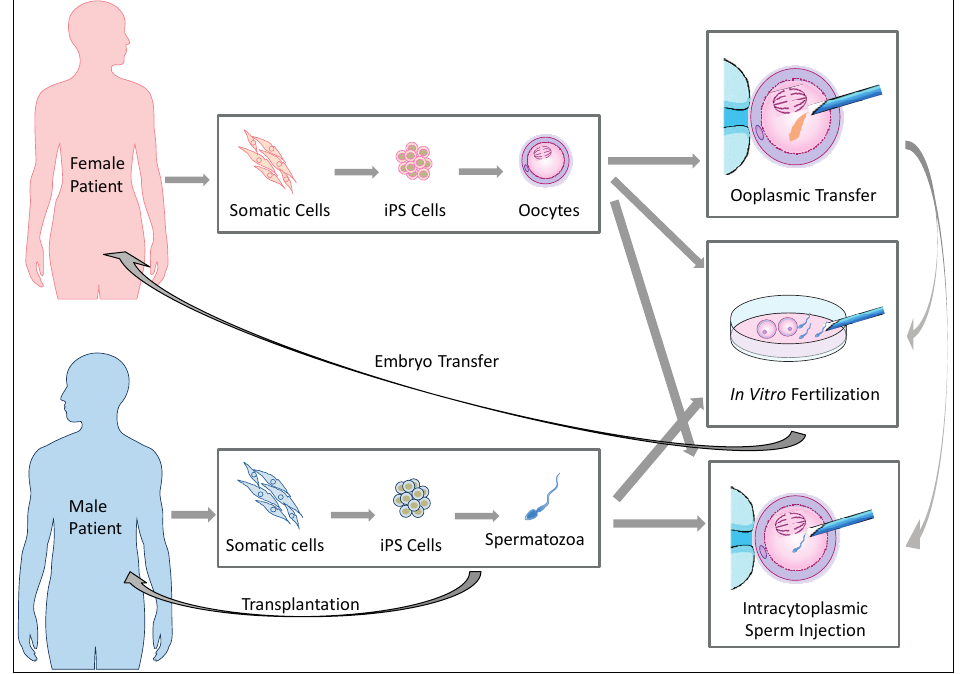
Figure 1. The potential reproductive uses of iPS cell-based germ cells. Autologous iPS cells can be generated from somatic cells biopsied from infertile patients who have lost viable oocytes or spermatozoa. Subsequently, germ cells are induced from the iPS cells. The regenerated germ cells can be used for in vitro fertilization or intracytoplasmic sperm injection to create embryos for transfer. In cases of male infertility, spermatogonial stem cells (SSCs) could be transplanted into patients to restore spermatogenesis potential. In cases of female infertility, ooplasmic transfer to enhance the viability of quality-compromised oocytes is conceivable if female germ cells with a sufficient number of mitochondria can be induced from iPS